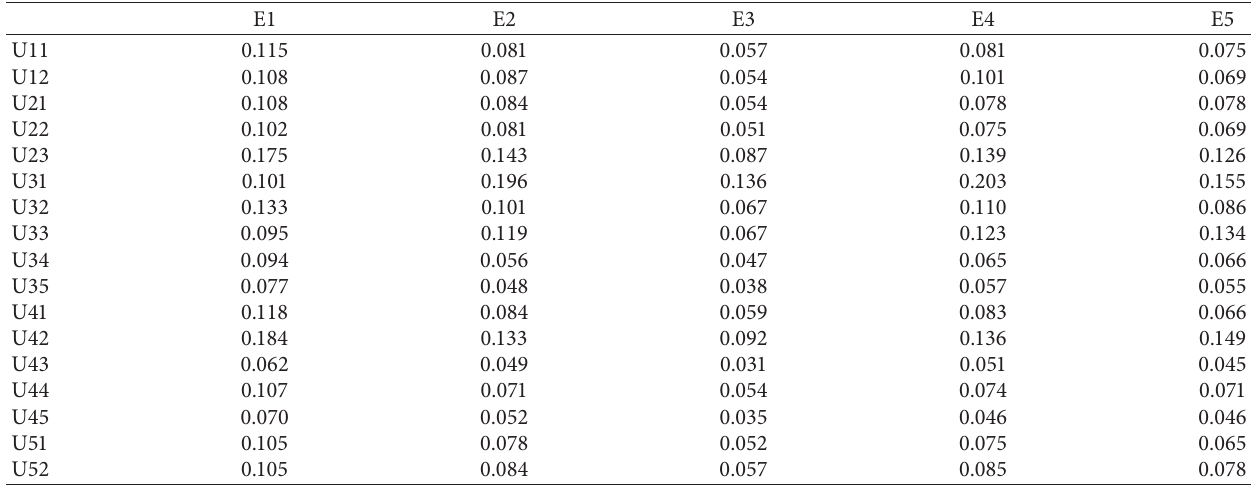
Table 8: Weighting matrix.